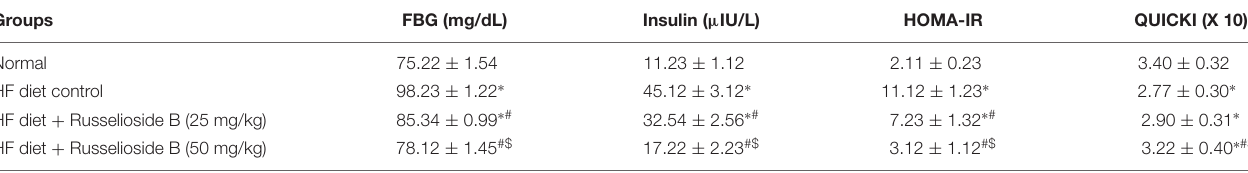
TABLE 3 | Effect of russelioside B (25 or 50 mg/kg) on fasting blood glucose, insulin, and insulin resistance indices. Groups